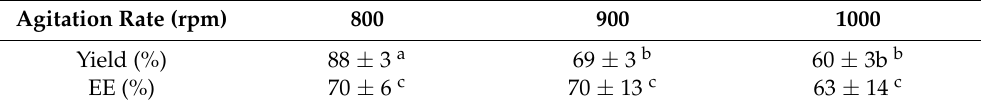
Table 1. Yield and encapsulation efficiency